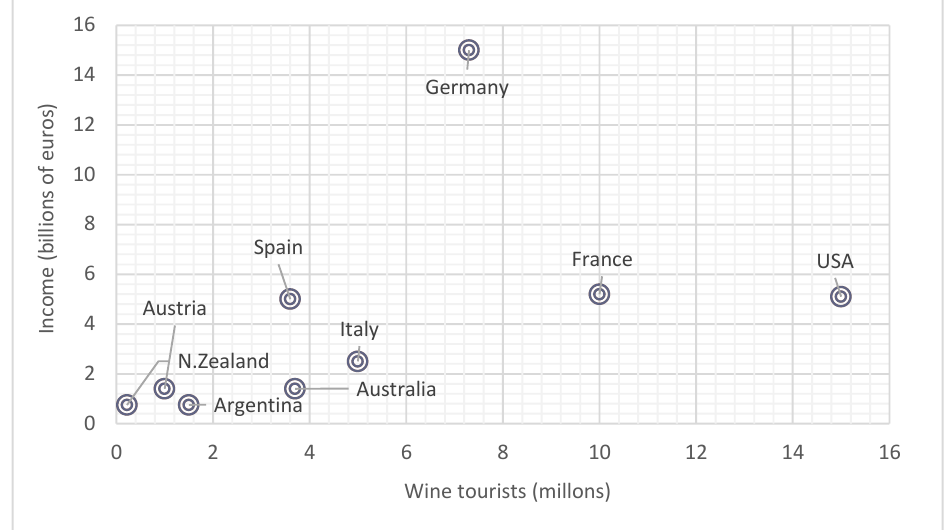
Figure 1. Wine tourists and wine tourism revenues in main countries (2019). Source: Own elaboration with data from Vins du Monde (Accueil (2021) Vins du monde. Available at: https://www.vinsdumonde.fr/ (accessed on 20 March 2023)).